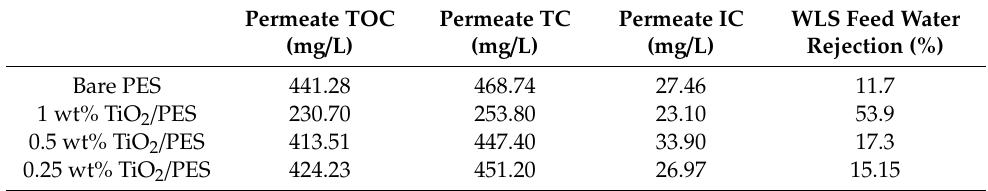
Table 3. Removal of organic matter from WLS inlet water (TOC: 500